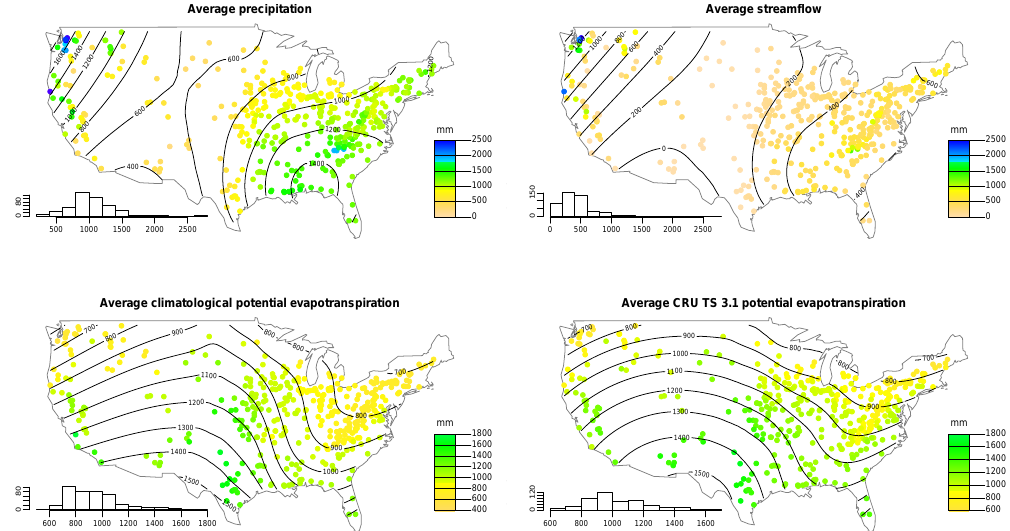
Fig. 1. Long-term annual average of hydroclimatic variables of the US MOPEX dataset (1949–2003). The contour lines are derived from fitted polynomial surfaces using the R function stats::loess (R Development Core Team, 2011) of the variables using the river gauge locations. The map of the US is taken from the maps package (Becker et al., 2011).